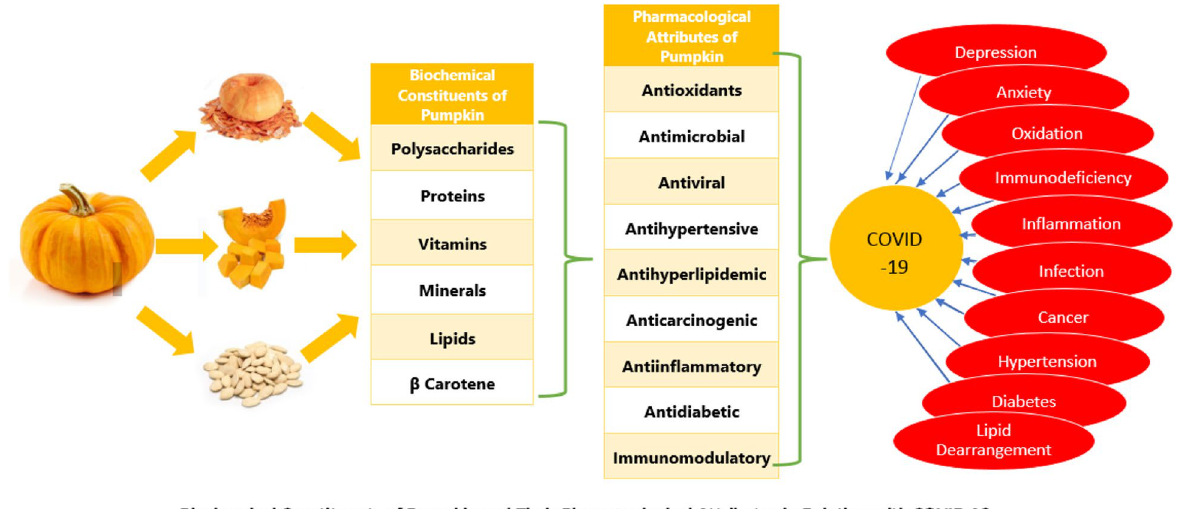
Fig. 1 Biochemical constituents of pumpkin and their pharmacological attributes in relation with COVID